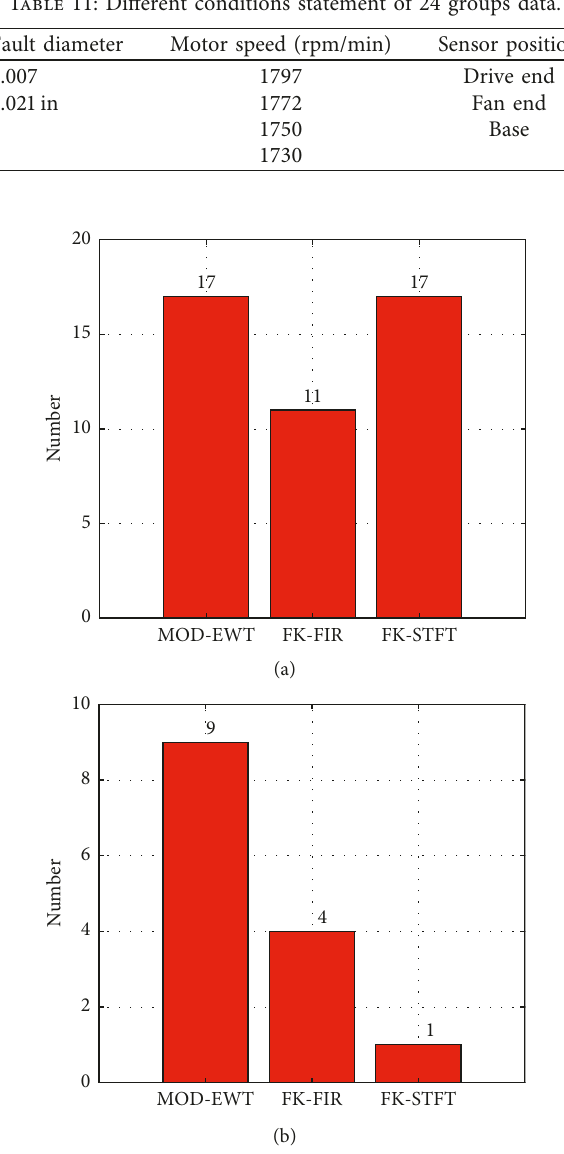
Figure 24: Number of groups with (a) diagnostic capability by using the results of three methods and(b) better diagnostic capa- bility by using the results of three